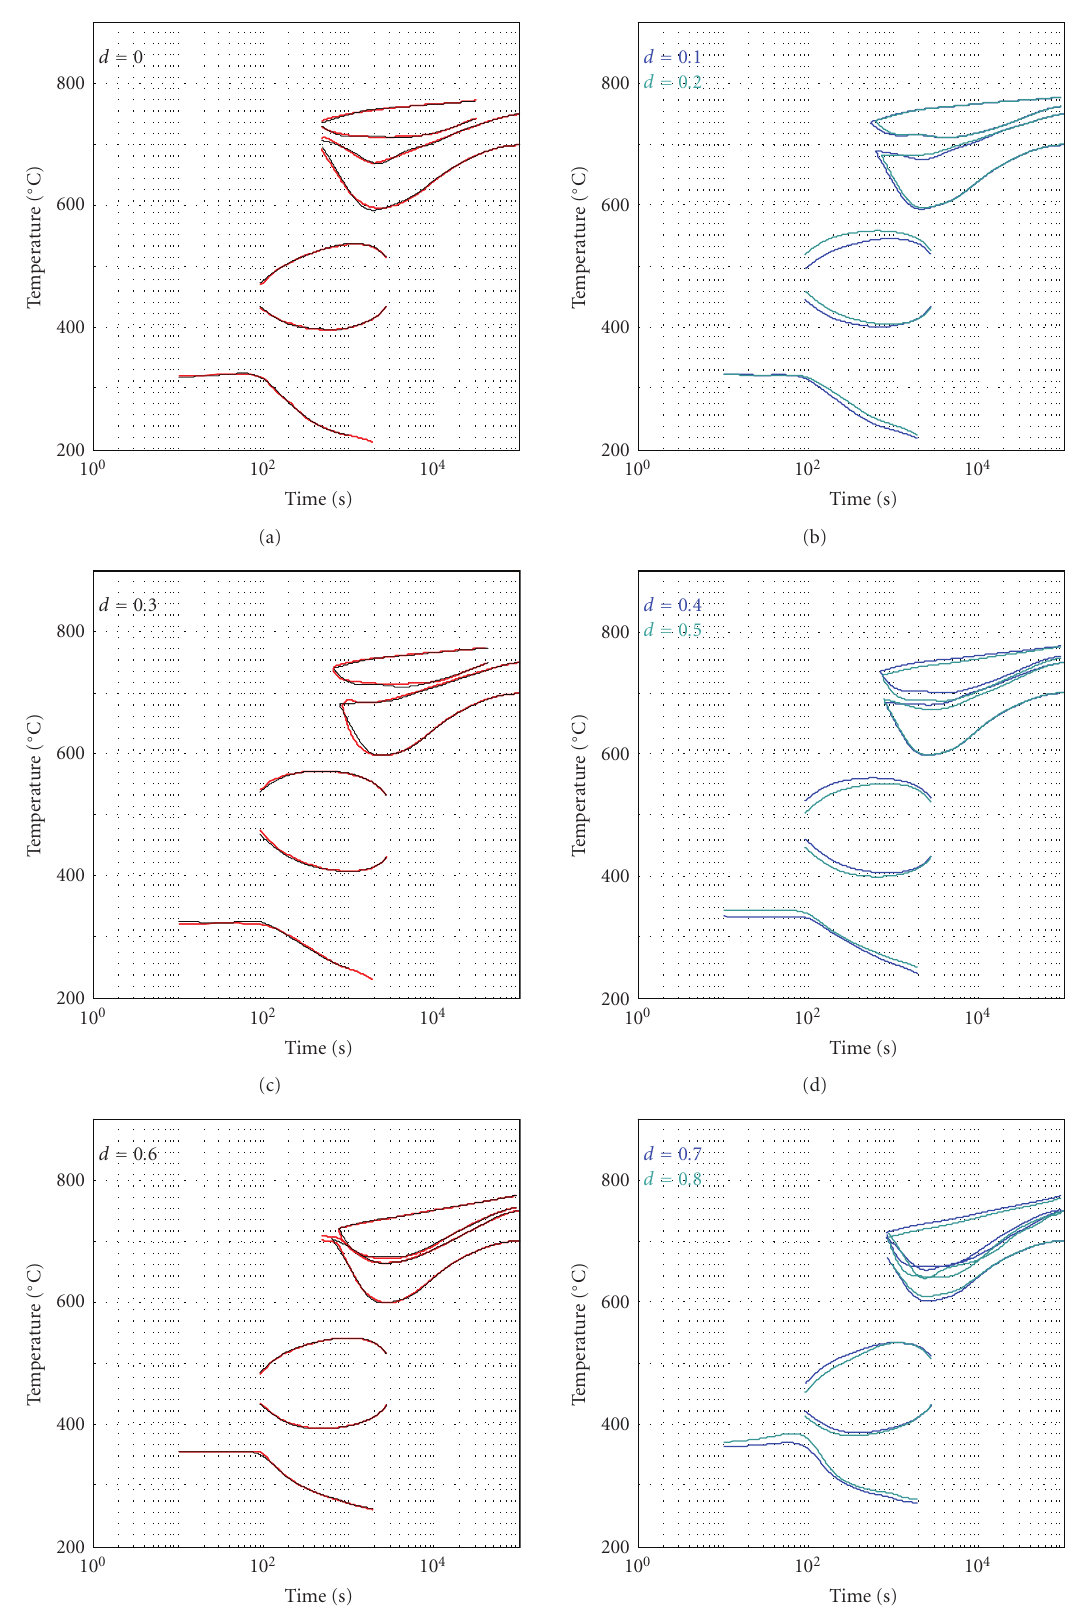
Figure 8: Dynamics of the microstructural transformations of the tempering steel